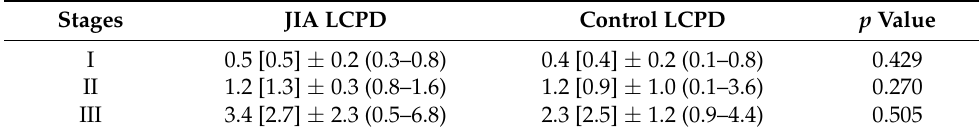
Table 4. Duration of the different stages of the Elizabethtown classification for the two study